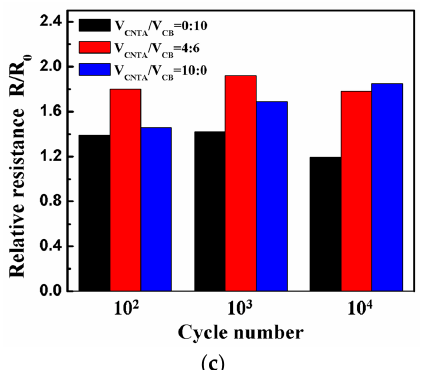
Figure 5. Fractional change of relative resistance R / R 0 as a function of the stretch-recovery cycle number for composites at different volume fractions of fillers: ( a ) 1.5 vol %, ( b ) 3 vol % and ( c ) 6 vol %.